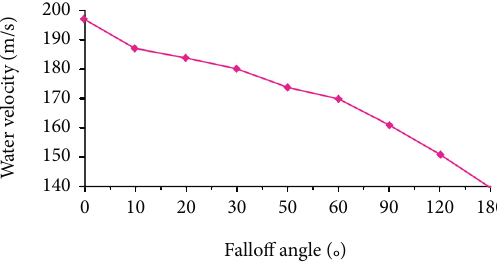
Figure 13: Relationship between the nozzle outlet velocity of the water jet and contraction angle.